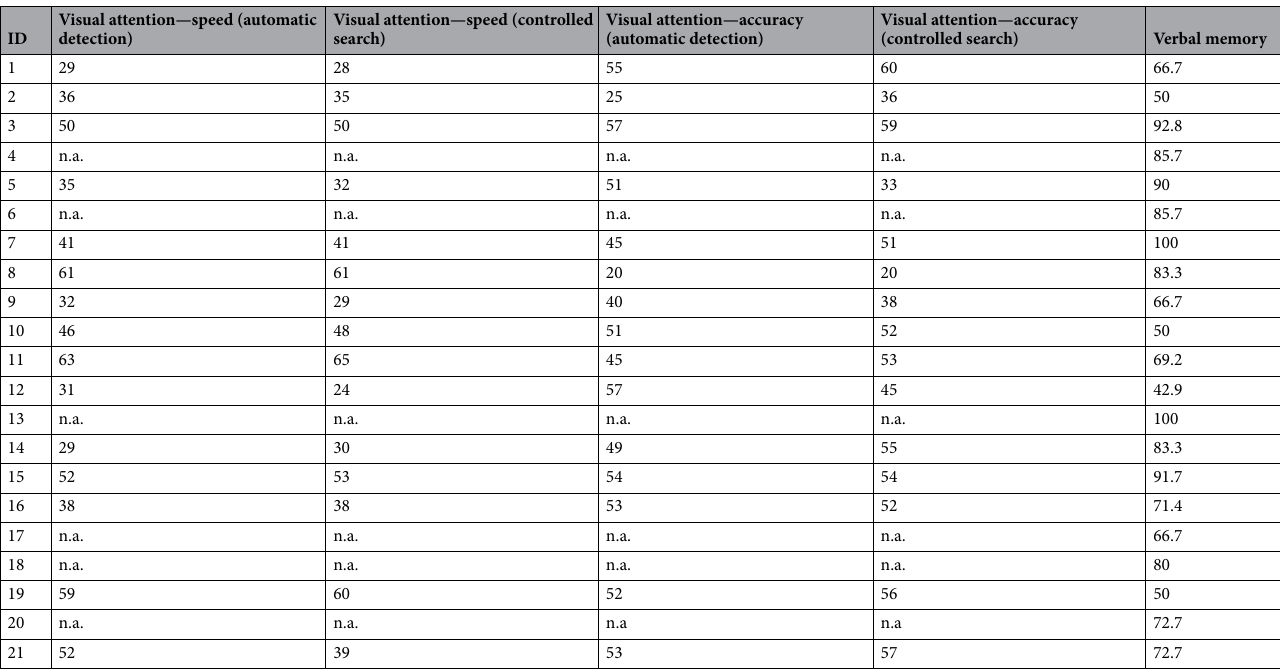
Table 3. Neuropsychological findings in patients with epilepsy (n = 21). Performance of visual attention task is reported in T-values, verbal memory performance in % of acquired words retained at delayed recall. n.a. not available.